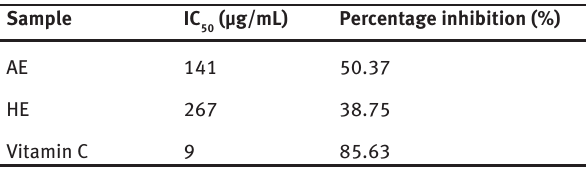
Figure 2: Proposed fragmentation pattern of compound 3. values of tested samples. Table 1: IC 50